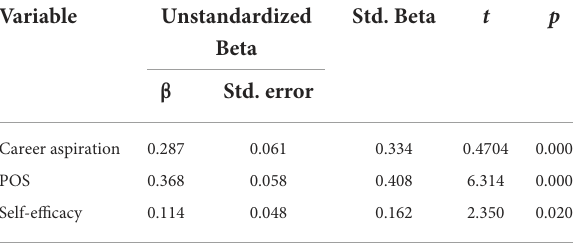
TABLE 2 Multiple linear regression for independent variables on subjective career success ( n = 146). Variable